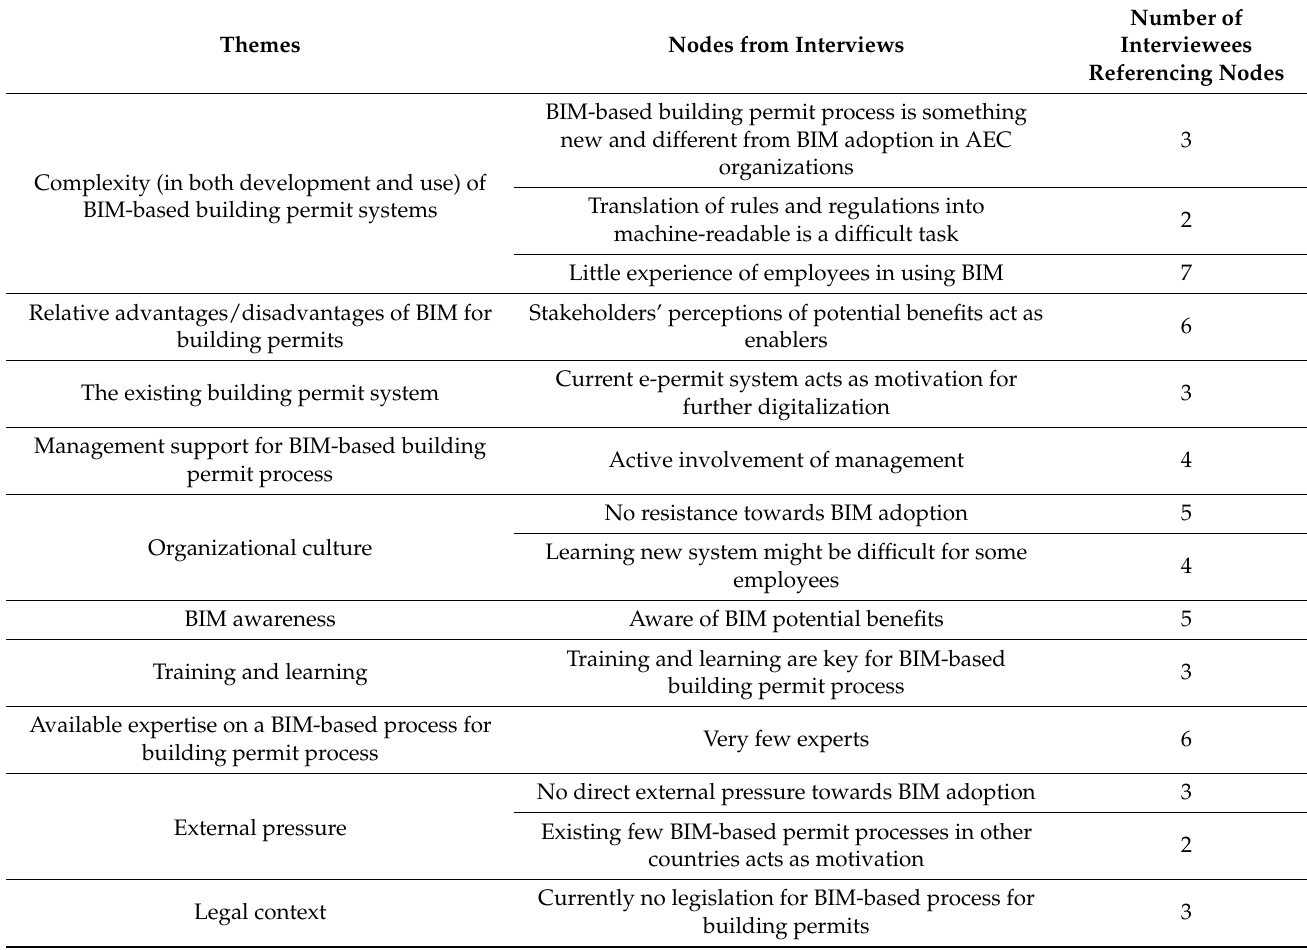
Table 3. Summary of prevalent responses from thematic